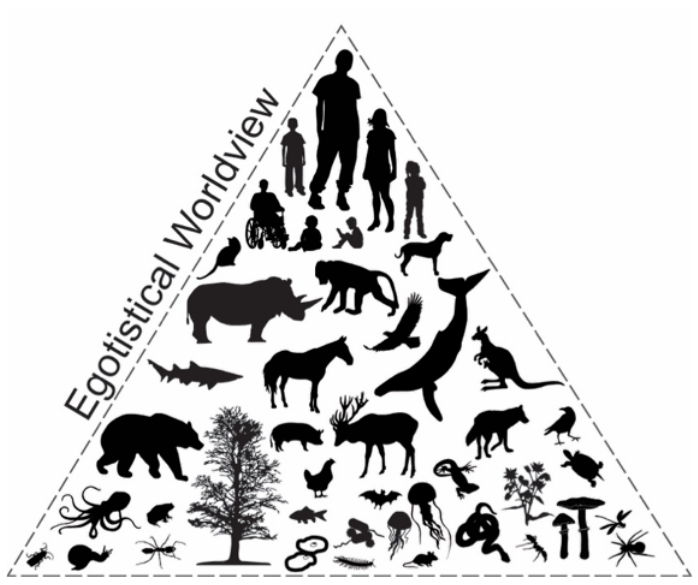
Figure 1. Egocentric Worldview adapted from “Differing Worldviews” (Martusewicz et al., 2015, p. 11). This figure illustrates the socially constructed hierarchical worldview of Western industrial culture.